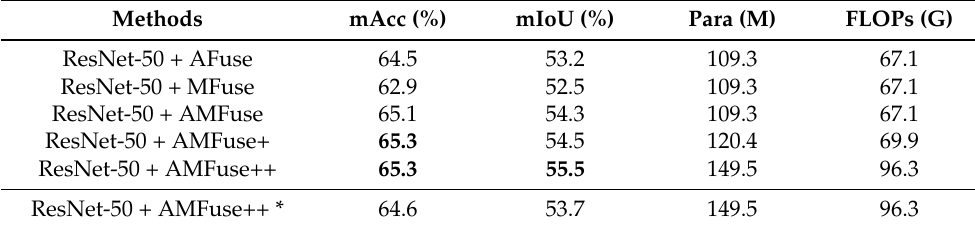
Table 6. The effectiveness of AMFuse serial modules based on the ResNet-50 backbone encoders.